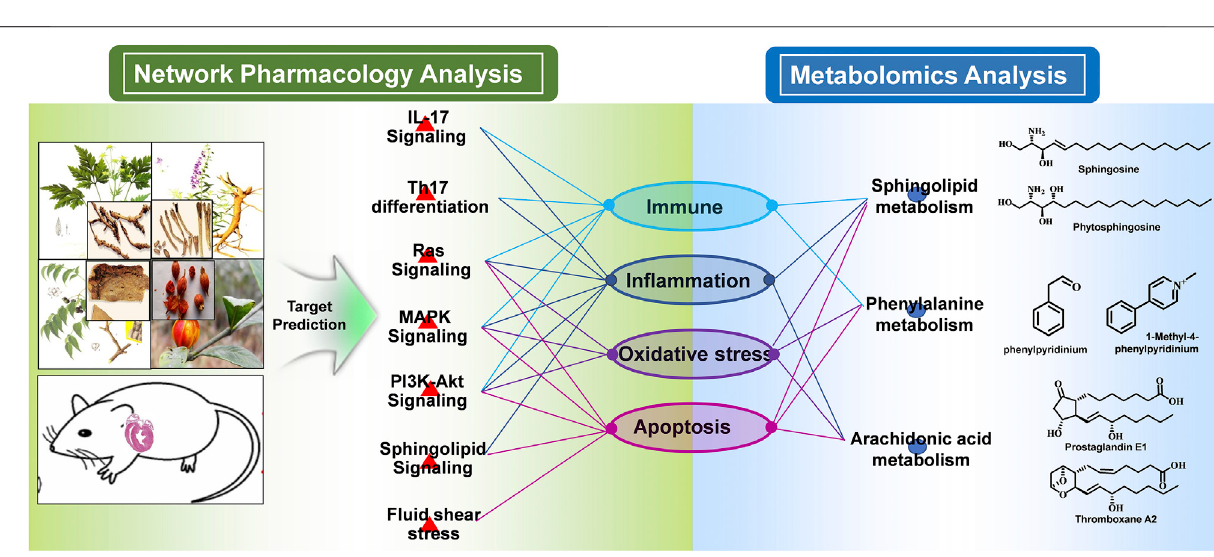
Frontiers in Pharmacology |